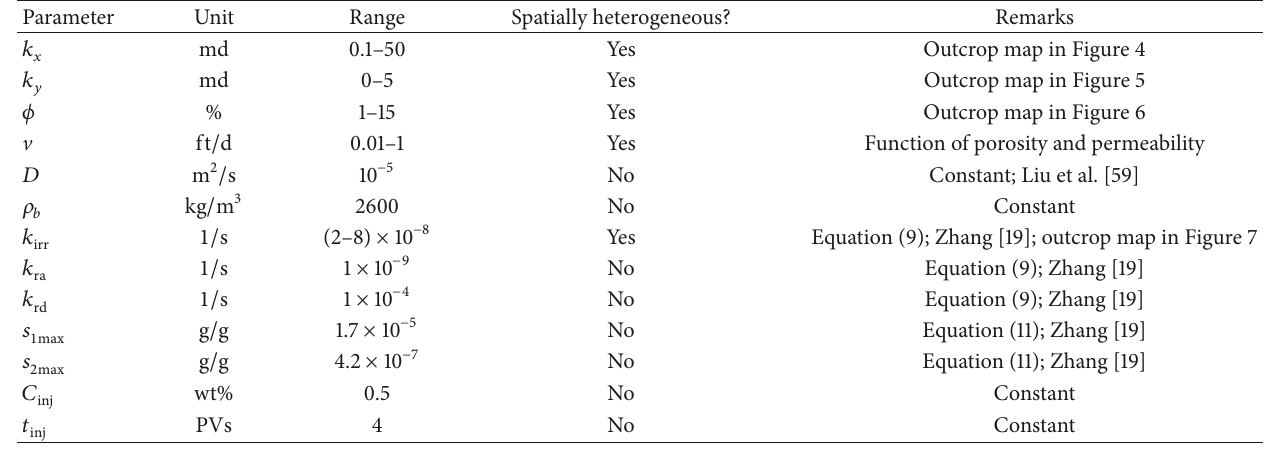
Table 2: Baseline parameters for seven outcrops at field scale.